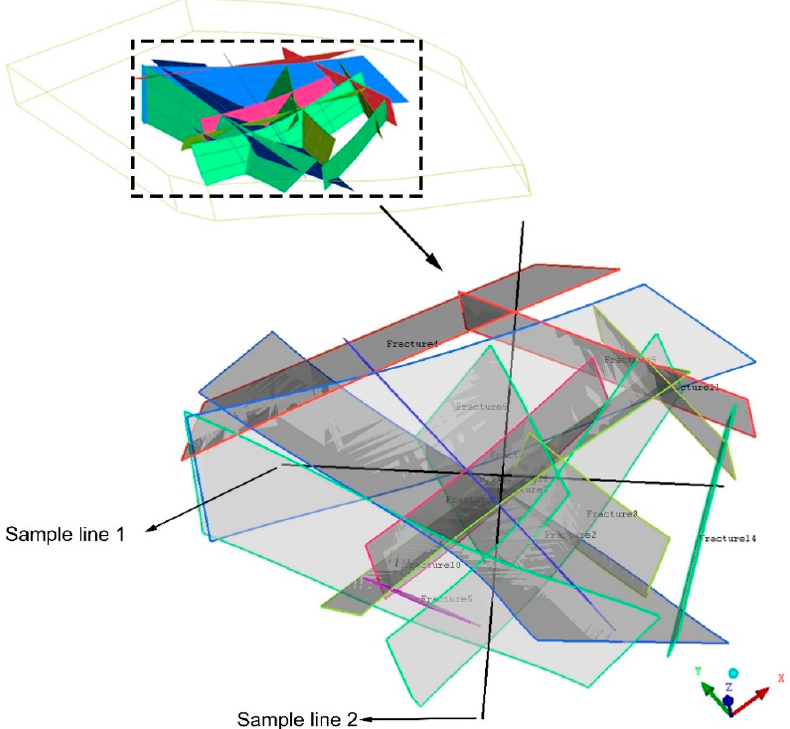
Figure 7. Schematic of stochastic fracture networks in the geothermal reservoir, and two sample line positions.